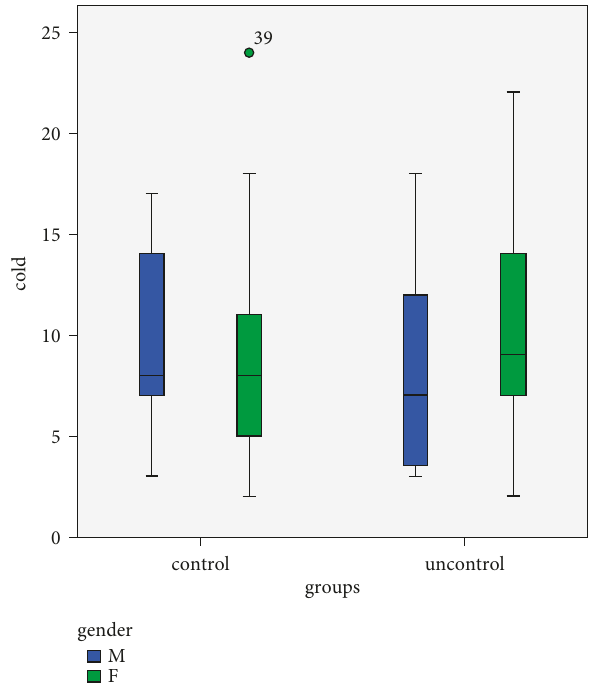
Figure 2: The relationship between the cold test and diabetes based on gender.